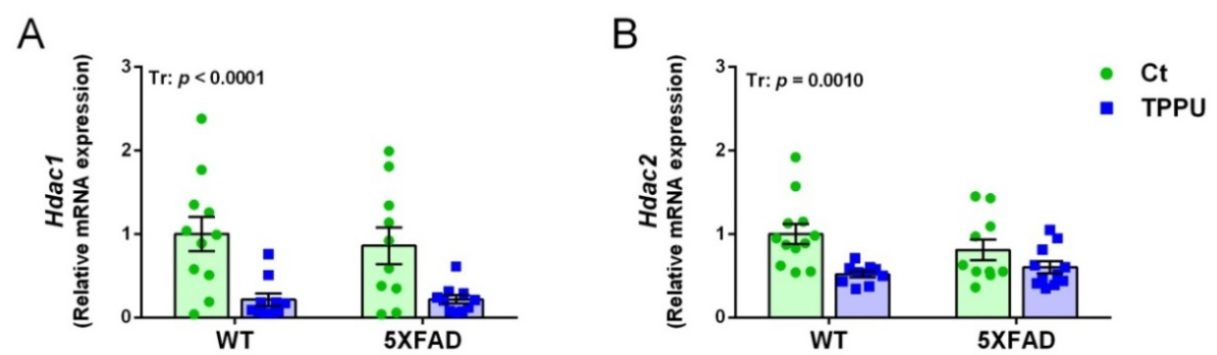
Figure 4. Histone deacetylation changes in the brain tissue of 2-month-old WT and 5XFAD mice from litters with maternal TPPU treatment or control (Ct). Expression levels of the histone deacetylase genes Hdac1 ( A ) and Hdac2 ( B ). ( A , B ) Hippocampus samples. Values are mean ± SEM of male and female mice (( A ) n = 10–11; ( B ) n = 10–12. Statistics: ANOVA, effect of treatment (Tr) in ( A , B ), p values of the significant factor are indicated in the corresponding graphs.